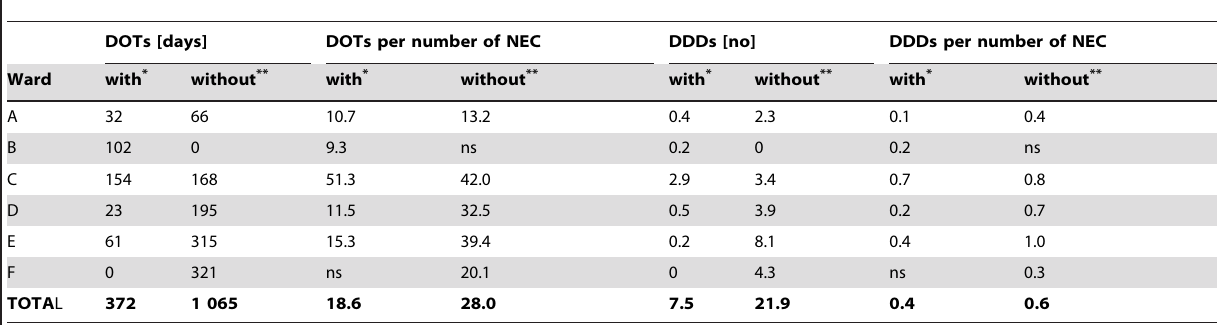
Table 4. Antibiotic usage in NEC cases with and without microbiology tests.